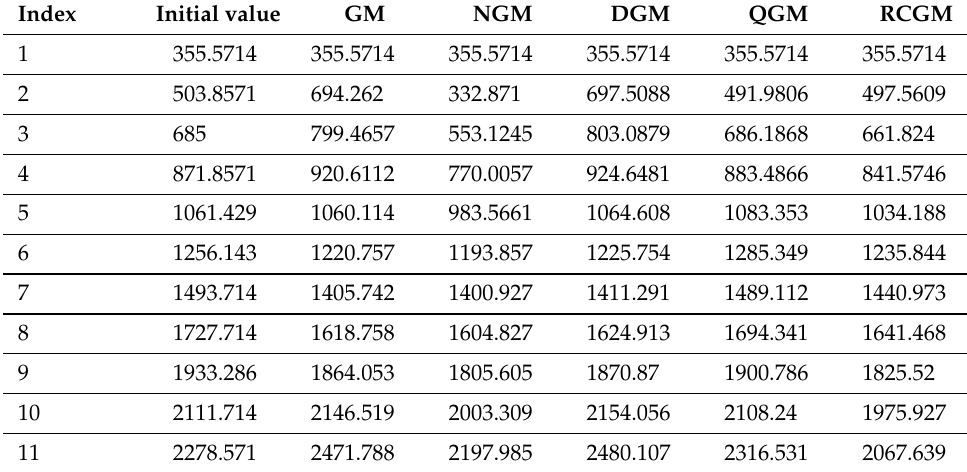
Table 4. Predicted values from Rajasthan data Model